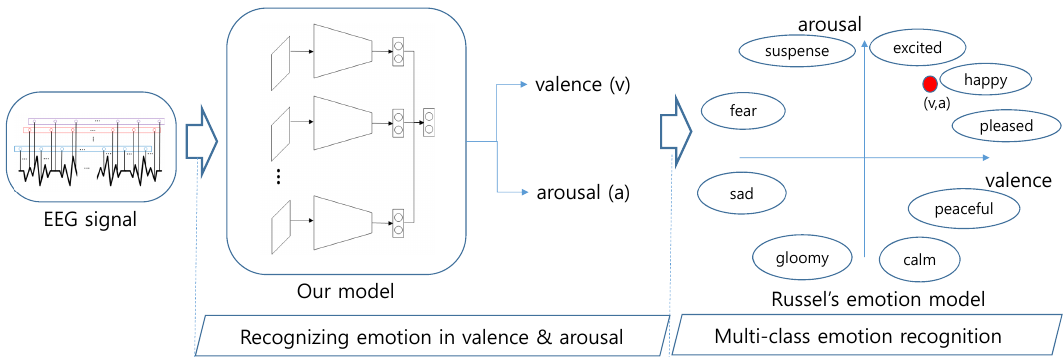
Figure 6. The process of multi-class emotion recognition. The result of our model, which is (valence, arousal), is mapped into the valence-arousal coordinate space of Russell’s